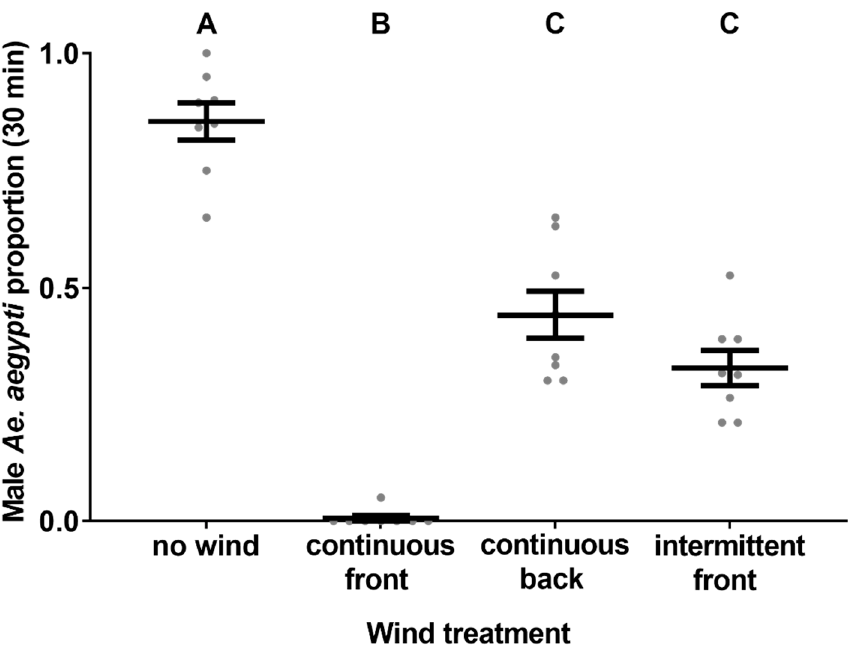
Figure 5. The influence of different wind conditions on male Ae. aegypti (mean ± S.E.) catch rates in the MAST. Different letters indicate significantly different groups (Tukey HSD, p ≤ 0.05, n = 7–8).